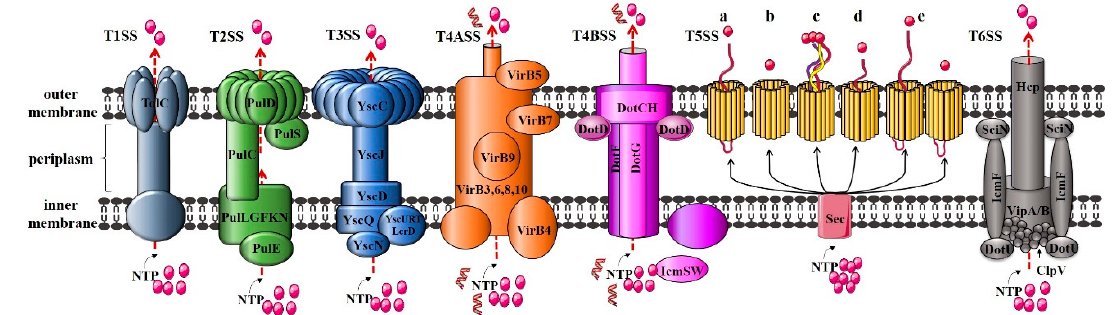
Figure 4. Protein components of T1SS to T6SS. T1SS: haemolysin A (HlyA) secretion system in Escherichia coli ; T2SS: pullulanase secretion system in Klebsiella oxytoca ; T3SS: yop secretion system in Yersinia ; T4ASS: VirB/VirD4 secretion system in Agrobacterium tumefaciens ; T4BSS: Dot/Icm system in Legionella pneumophila ; T5SS: Type Va (autotransporter system); Type Vb (two-partner secretion systems); Type Vc (trimeric autotransporters); Type Vd (encoding a patatin-like passenger domain fused to a C-terminal β -barrel domain that resembles TpsB proteins); Type Ve (inverse autotransporters and two-partner inverse autotransporters); and T6SS: secretion system in Vibrio cholera .